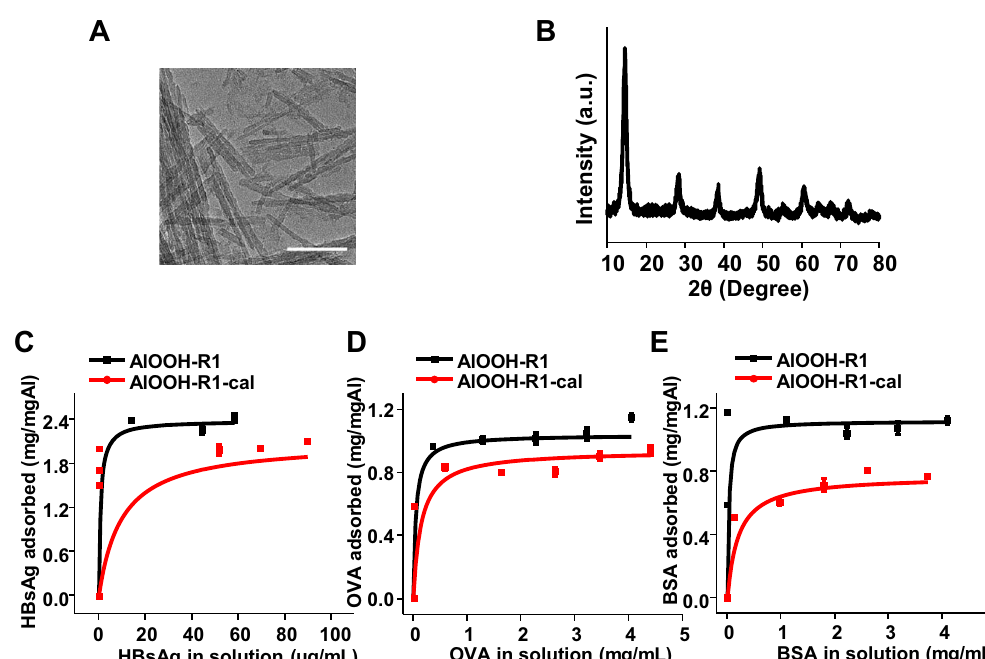
Fig. 3 Effect of speci fi c surface area and surface hydroxyl content of AlOOH nanorods on antigen adsorption. A TEM analysis and B XRD patterns of the AlOOH-R1 after calcination. AlOOH-R1-cal was obtained by treating AlOOH nanorods at 350 °C for 1 h. The scale bar is 100 nm. Adsorption isotherms of C HBsAg, D OVA, and E BSA by AlOOH-R1 and AlOOH-R1-cal in MOPS buffer at pH